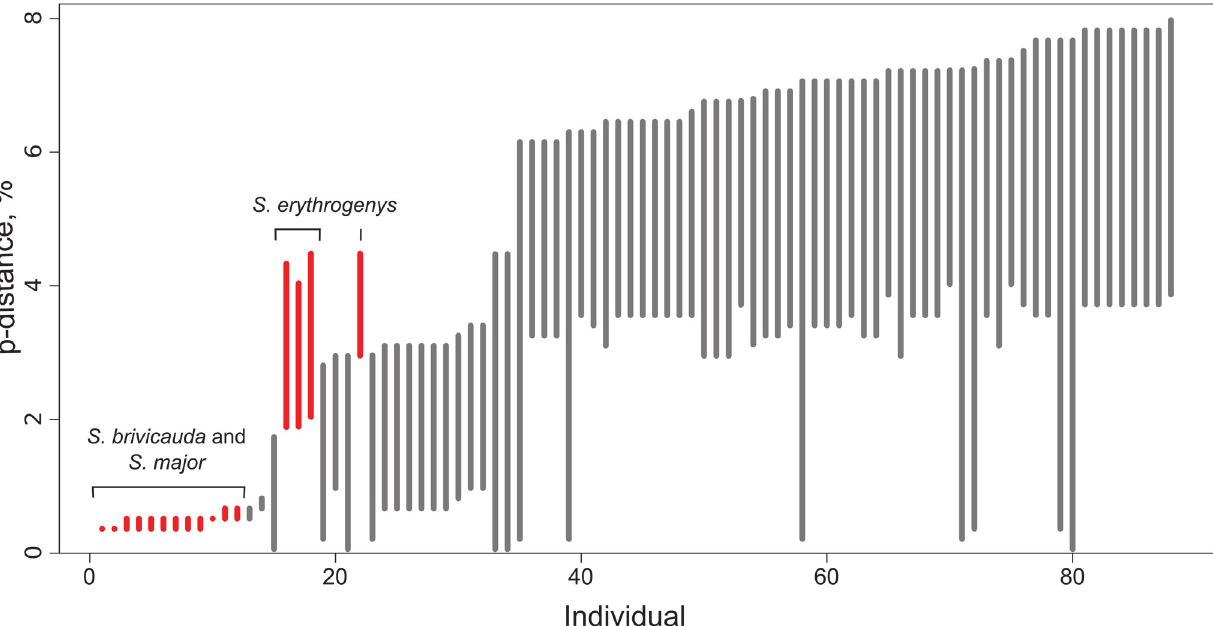
Figure 4. Line-plot of the barcode gap for the Eurasian ground squirrels as generated by Spider [40]. For each individual in the dataset, the grey lines represent the furthest intraspecific distance (bottom of line value), and the closest interspecific distance (top of line value). The red lines show where this relationship is reversed, and the closest non-conspecific is actually closer to the query than its nearest conspecific (i.e. no barcoding gap). Individuals with introgressed mtDNA are not